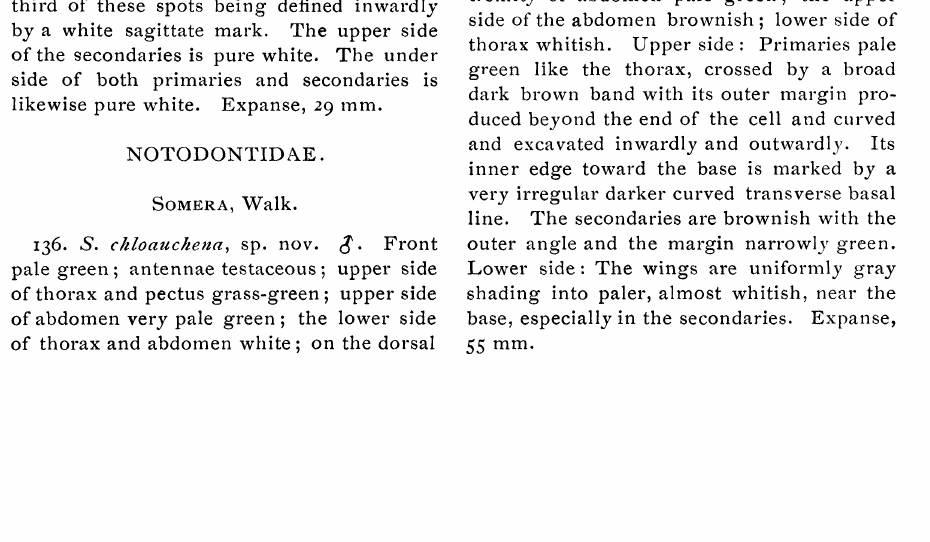
tremity of abdomen pale green; the upper side of the abdomen brownish; lower side of thorax whitish. Upper side: Primaries pale green like the thorax, crossed by a broad dark brown band with its outer margin pro- duced beyond the end of the cell and curved and excavated inwardly and outwardly. Its inner edge toward the base is marked by a very irregular darker curved transverse basal line. The secondaries are brownish with the outer angle and the margin narrowly green. Lower side:The wings are uniformly gray shading into paler, almost whitish, near the base, especially in the secondaries.